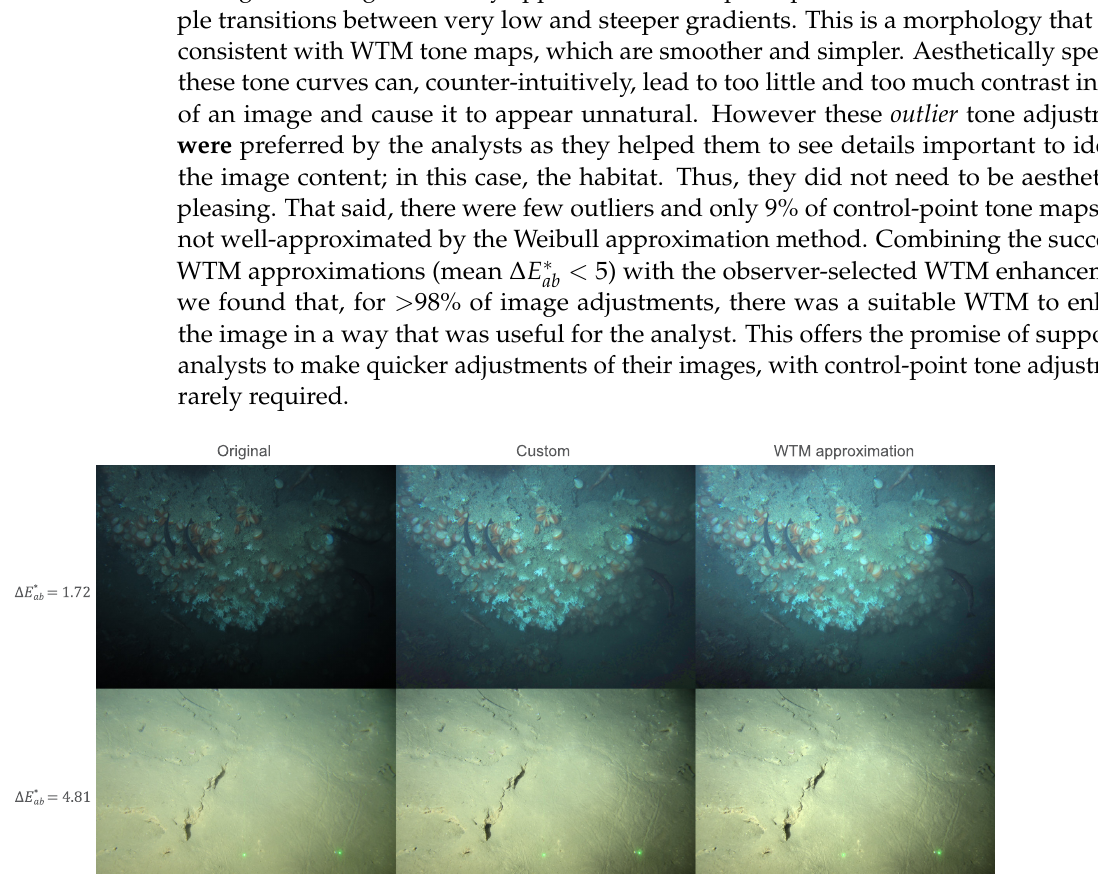
across pixel ab